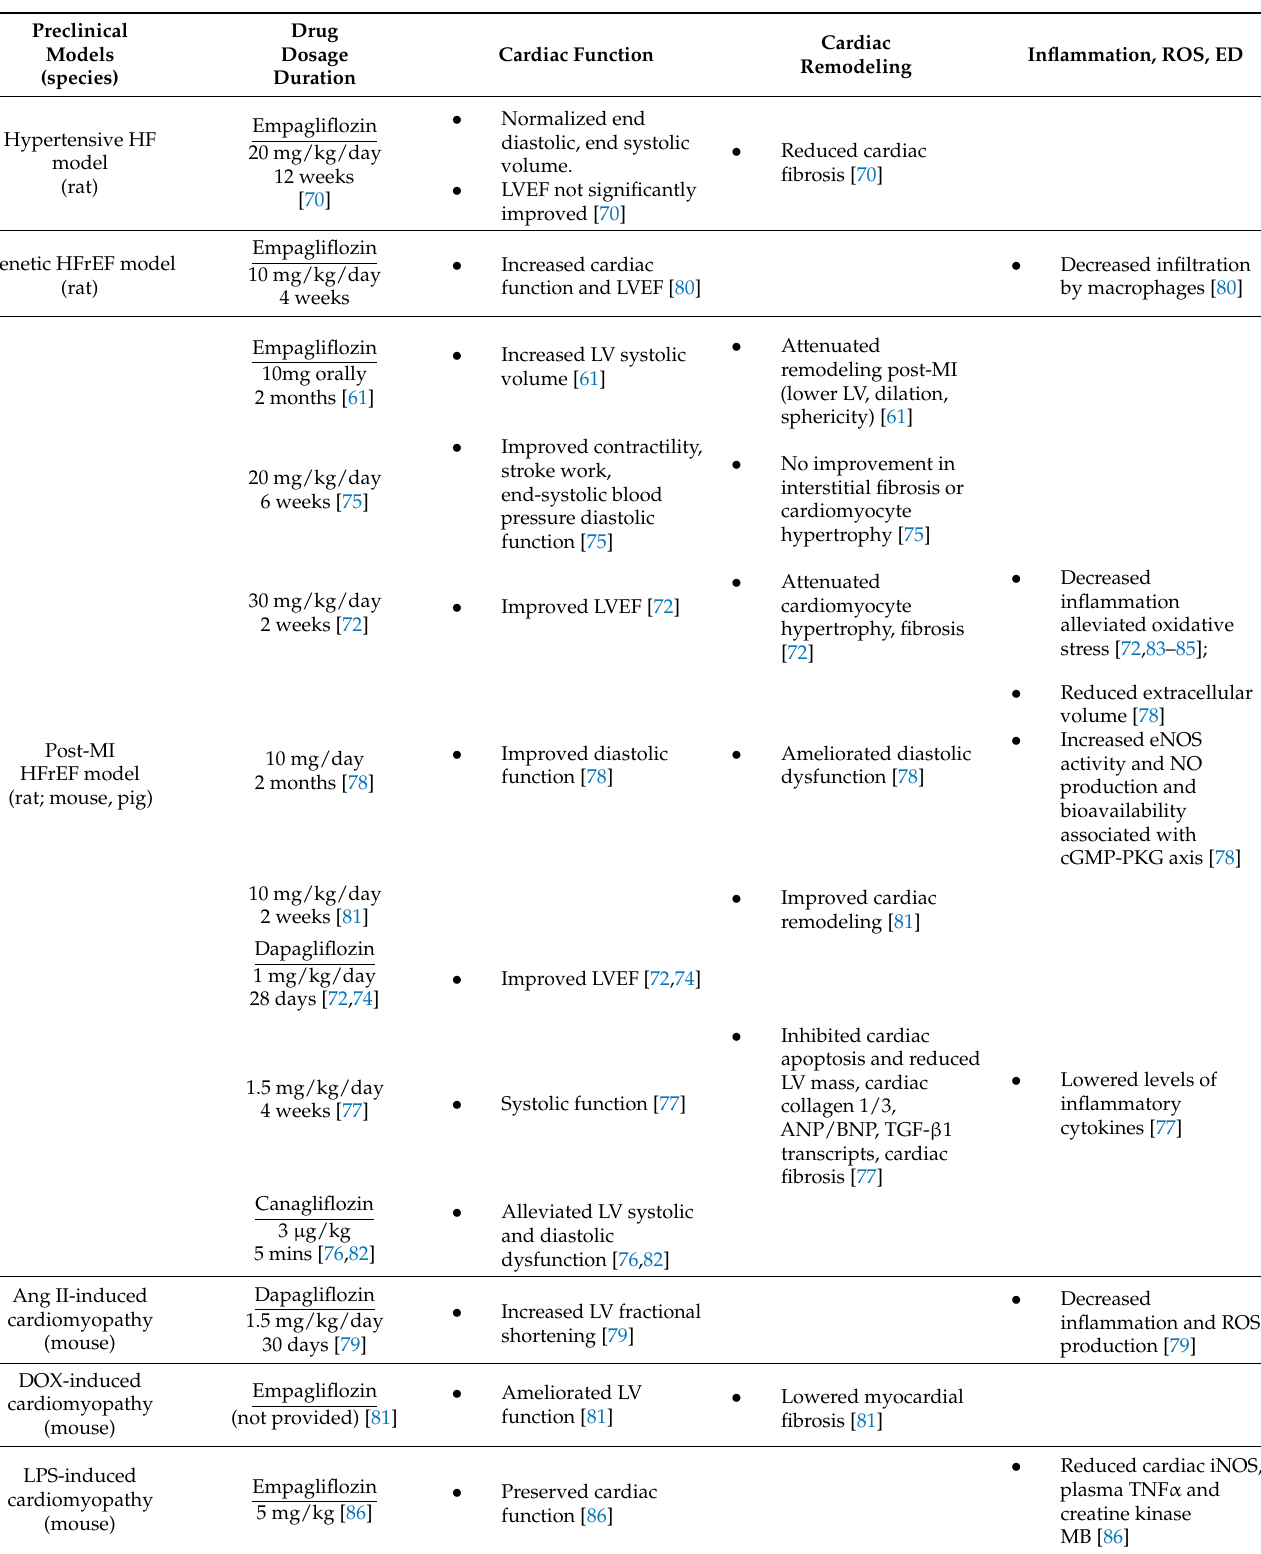
Table 1. Cardiac outcomes of treatments with SGLT-2i in pre-clinical models of